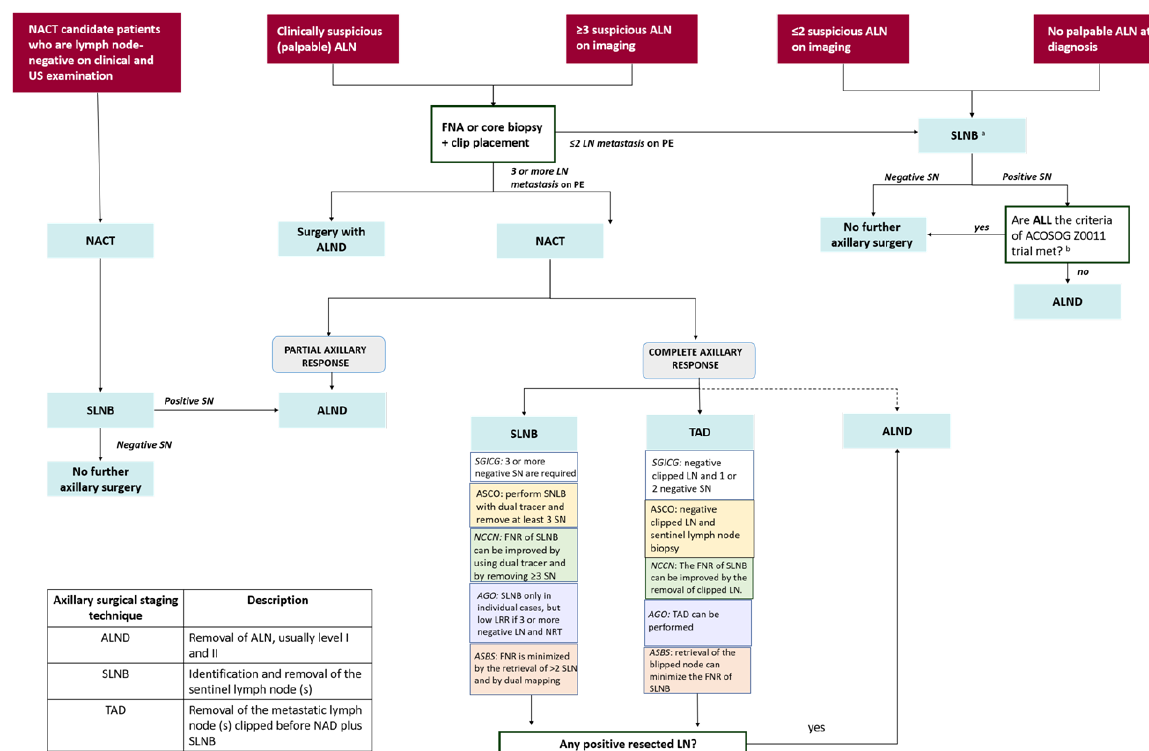
Figure 1. ALN management is illustrated based on current guidelines. a If a positive LN is clipped at biopsy, every effort should be made to remove the clipped node at the time of surgery. b They include: T1 or T2 tumor, clinically negative nodes, 1 or 2 positive nodes on SLNB, planned breast-conserving surgery, planned whole-breast radiation therapy, no NACT planned. Abbreviations: FNA: fine needle aspiration; PE: pathological examination; NRT: nodal radiotherapy; LRR: local recurrence rate; NACT: Neoadjuvant chemotherapy; SLNB: sentinel lymph node biopsy; TAD: targeted axillary dissection; ALND: ALN dissection; FNR: false negative rate; SGICG: St. Gallen International Consensus Guidelines; ASCO: American Society of Clinical Oncology; NCCN: National Comprehensive Cancer Network; AGO: Breast Committee of the German Gynaecological Oncology Working Group; ASBS: American Society of Breast Surgeon.